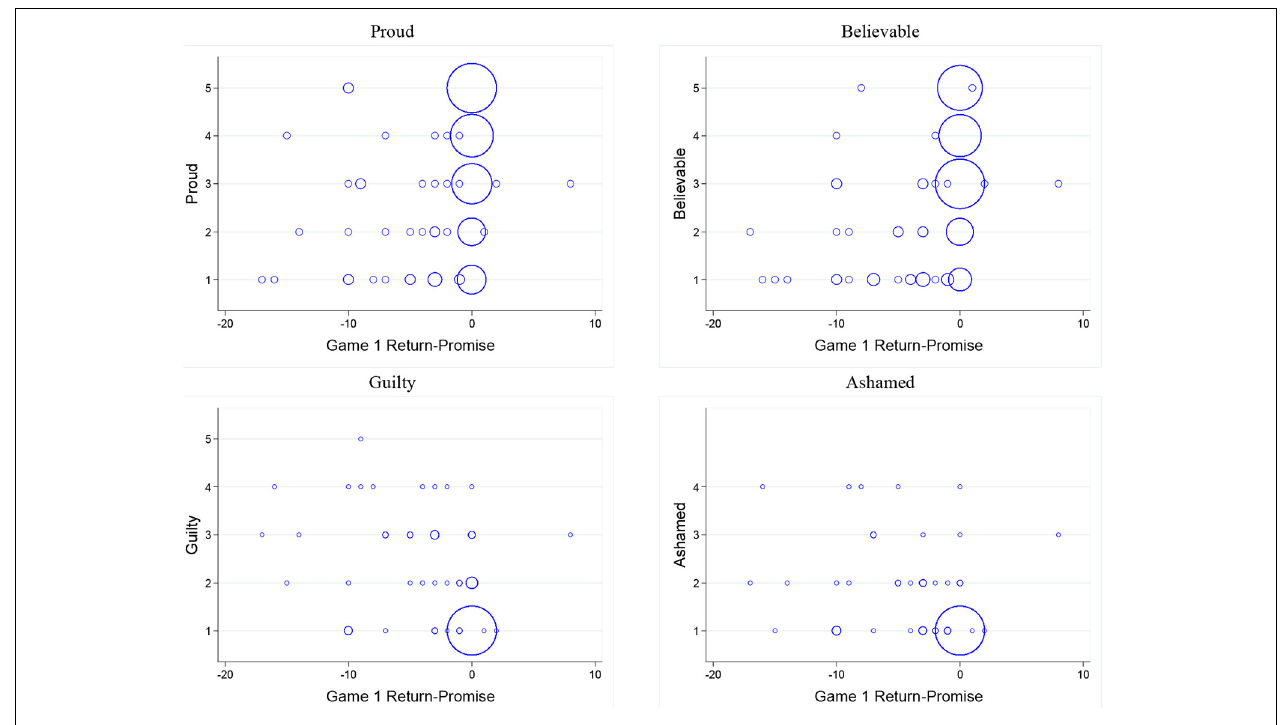
FIGURE 2 | Bubble plots of trustees’ emotions and Signal value .